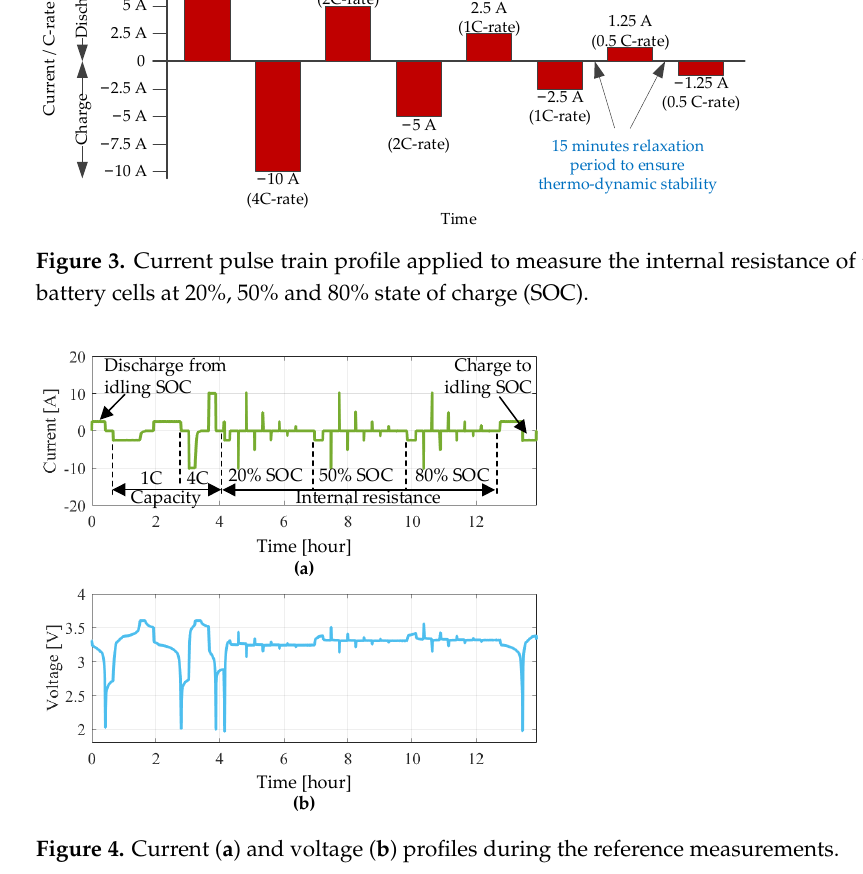
Figure 4. Current ( a ) and voltage ( b ) profiles during the reference measurements.